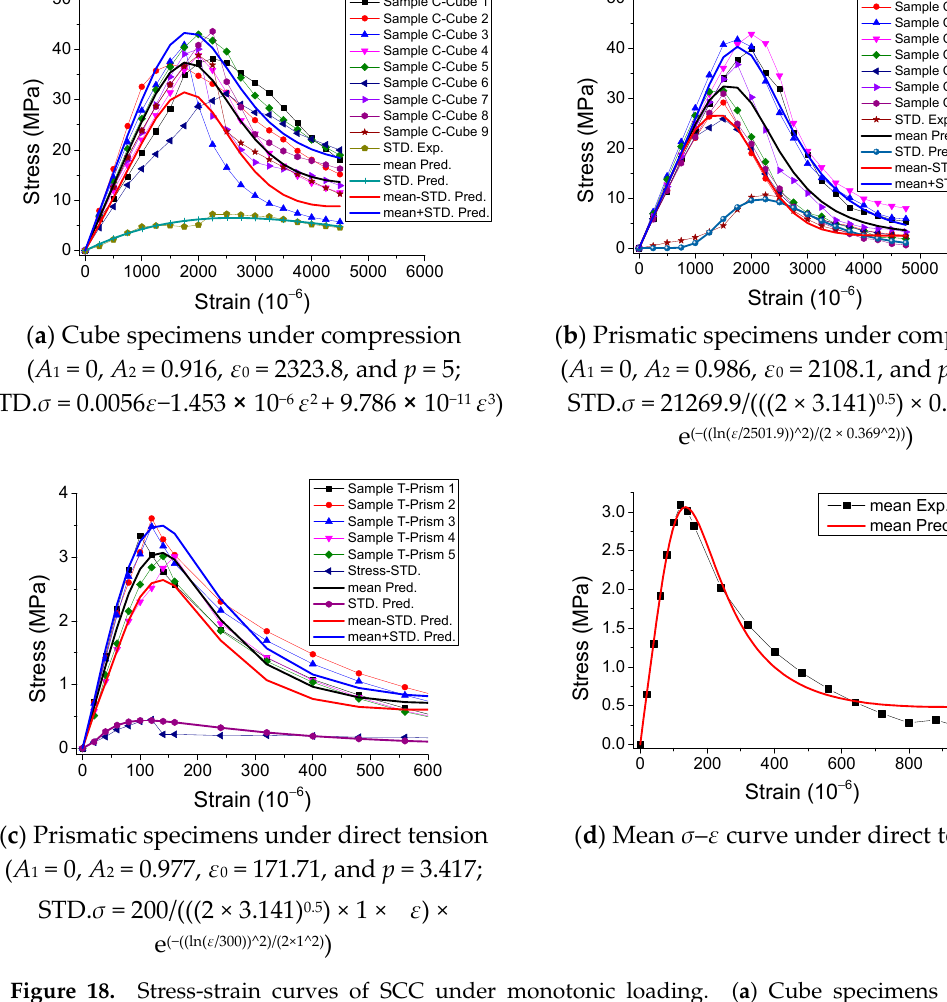
Sample C-Cube 1 Sample C-Cube 2 Sample C-Cube 3 Sample C-Cube 4 Sample C-Cube 5 Sample C-Cube 6 Sample C-Cube 7 Sample C-Cube 8 Sample C-Cube 9 STD. Exp. mean Pred. STD. Pred.